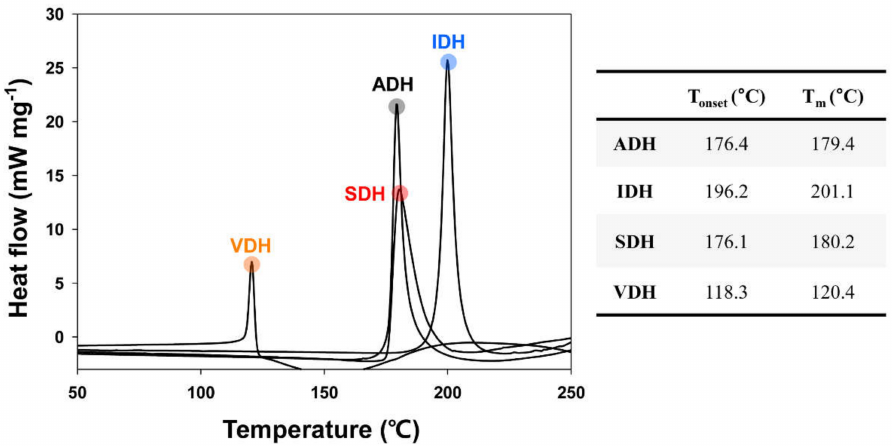
Figure 3. Differential scanning calorimetry (DSC) thermograms of various dihydrazide compounds at heating rate of 10 ◦ C min − 1 .